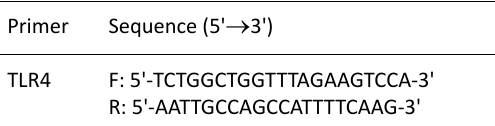
Table 1. Primer sets used in the present